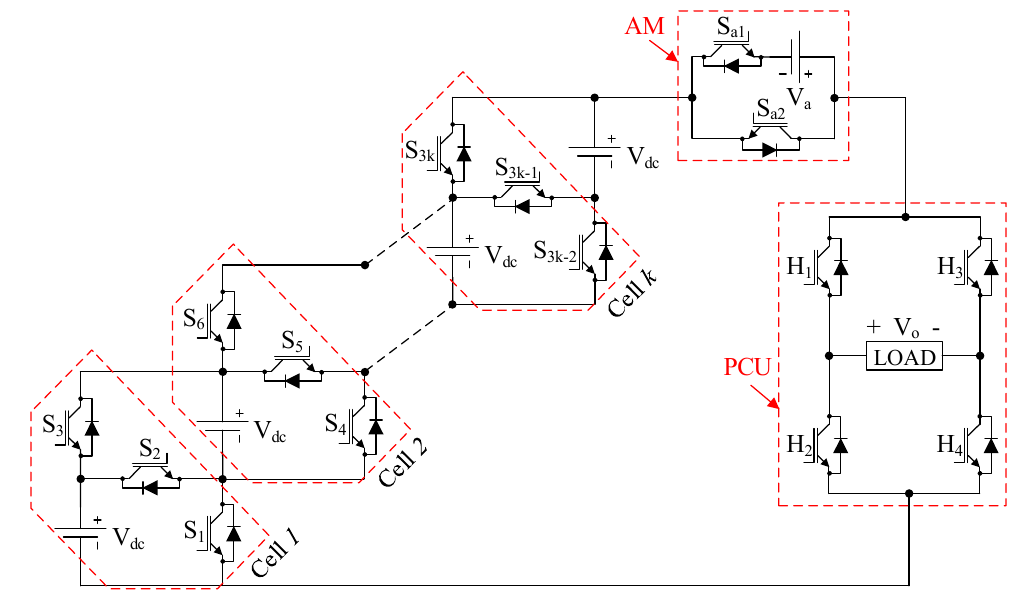
Figure 4. The generalized structure of the proposed multilevel inverter topology.